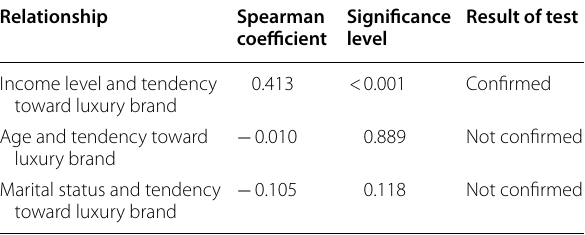
Table 10 Spearman correlation test on relationship between demographic factors and tendency to